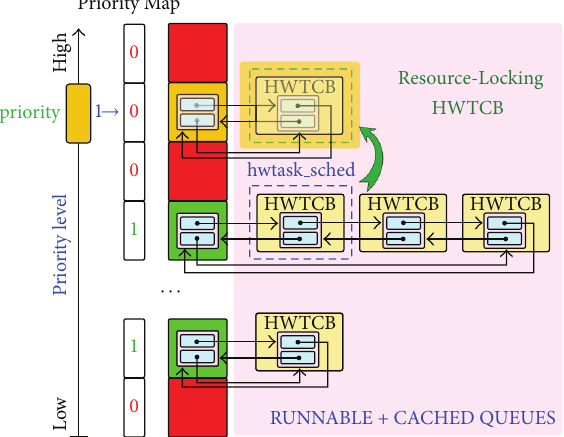
Figure 8: HWT Ready Queues and RR